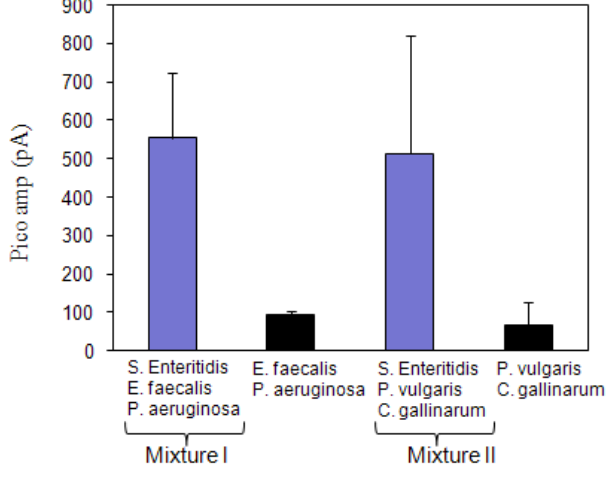
Figure 2. Fiber-optic signal recognition of Salmonella Enteritidis in a mixed bacterial culture. In mixture I, S. Enteritidis was used at 1 × 10 5 cfu/mL while Enterococcus faecalis and Pseudomonas aeruginosa at 1 × 10 6 cfu/mL each. In mixture II, S. Enteritidis was used at 1 × 10 5 cfu/mL while Proteus vulgaris and Carnobacterium gallinarum at 1 × 10 6 cfu/mL